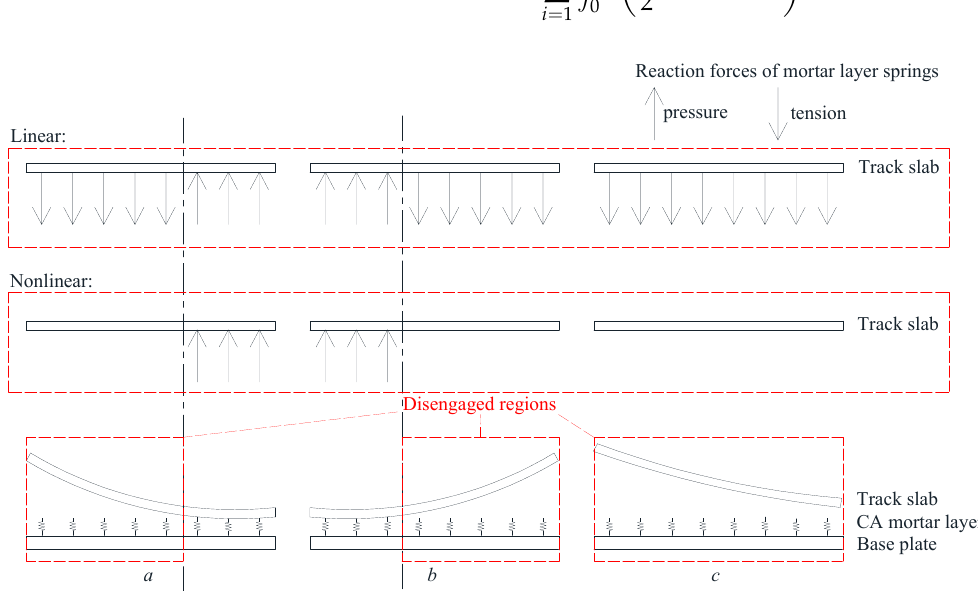
Figure 2. Schematic drawing of track slab disengagement and the reaction forces of mortar layer to the track slabs ( a ), and ( b ) partial track slab disengagement; ( c ) full track slab disengagement.